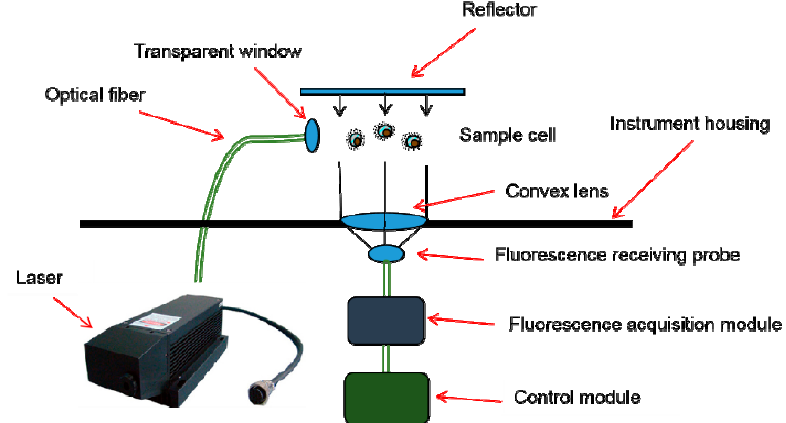
Figure 1. Schematic of a laser-induced fluorescence (LIF) system.